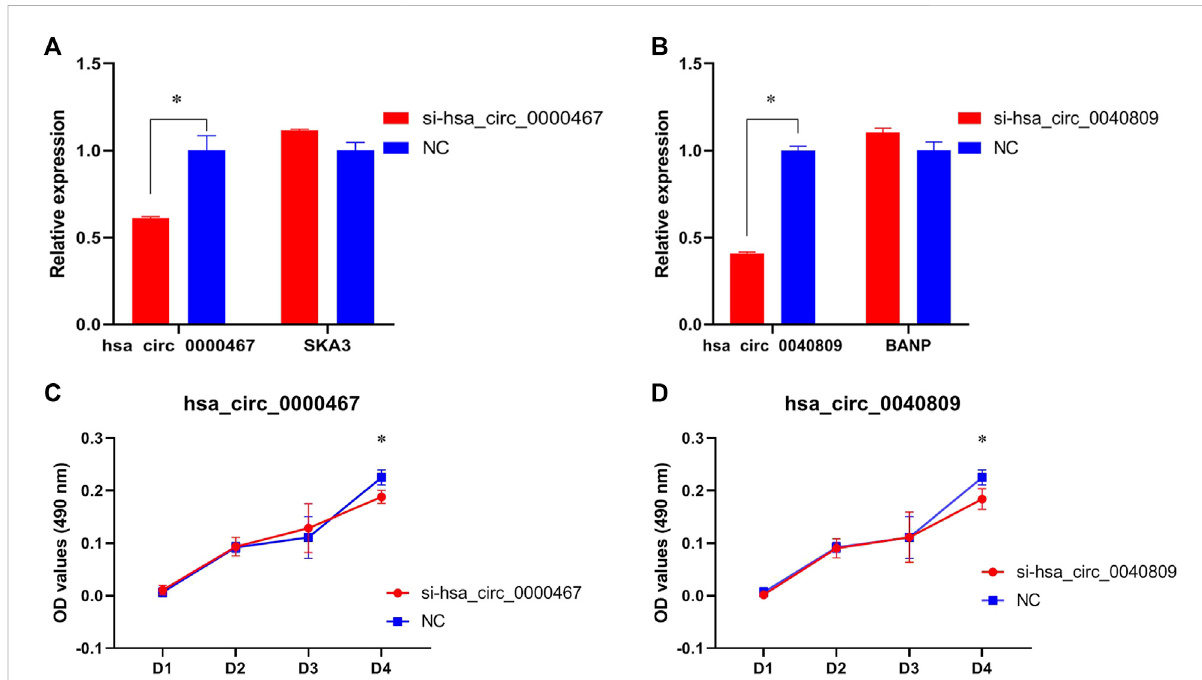
FIGURE 3 Hsa_circ_0040809 and hsa_circ_0000467 promote HCT29 cells proliferation. (A) The relative expressions of hsa_circ_0000467 and host gene SKA3 in siRNA-hsa_circ_0000467 and NC HCT29 cells. (B) The relative expressions of hsa_circ_0040809 and host gene BANP in siRNA- hsa_circ_0040809, and NC HCT29 cells. (C) The effect of siRNA-hsa_circ_0000467 on HT29 cells proliferation. (D) The effect of siRNA- hsa_circ_0040809 on the HT29 cells